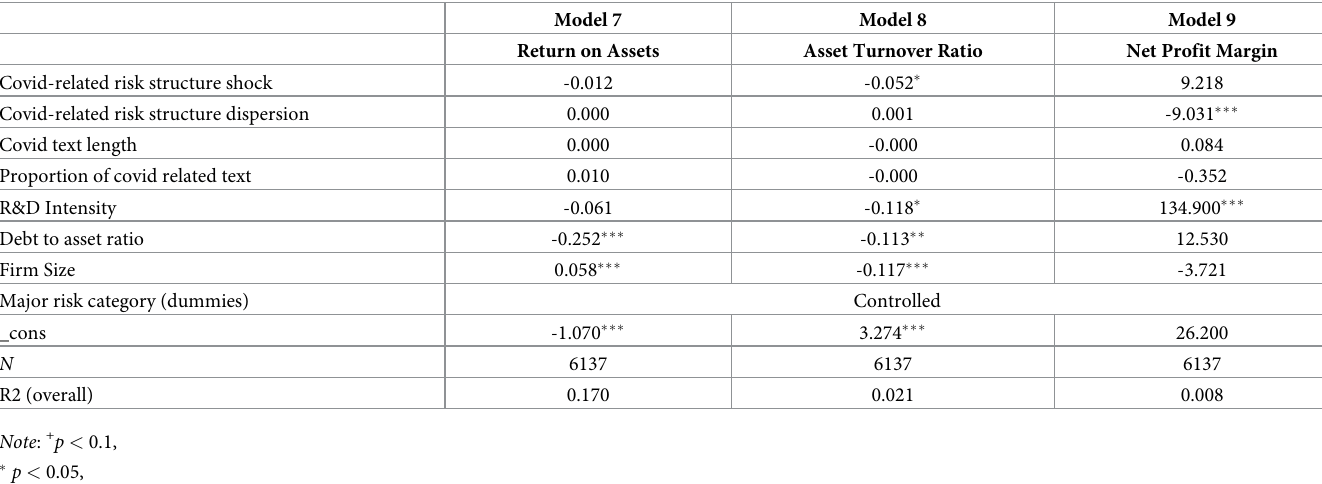
Table 3. Fixed effect model of covid-19 risk shock on company